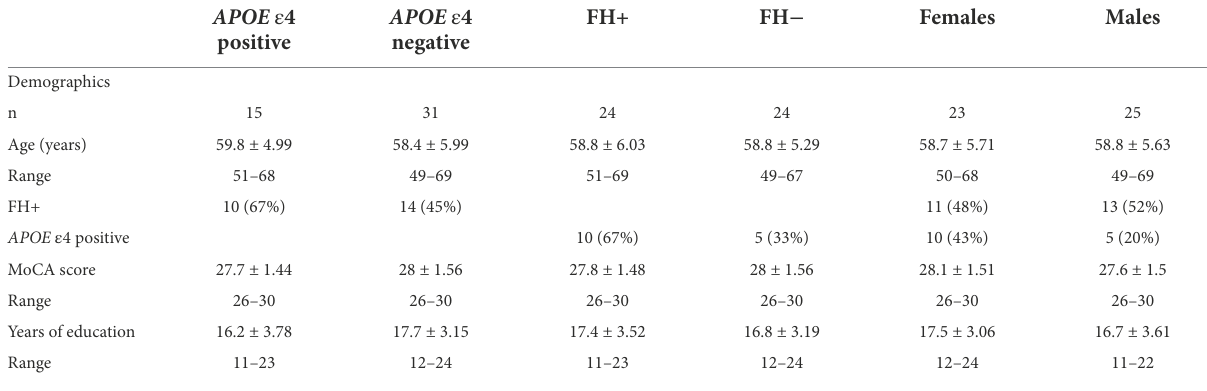
TABLE 1 Participant demographic